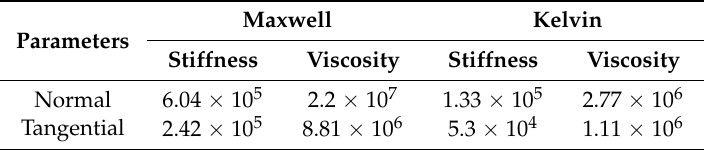
Table 3. Micromechanical parameters of Burger’s model.